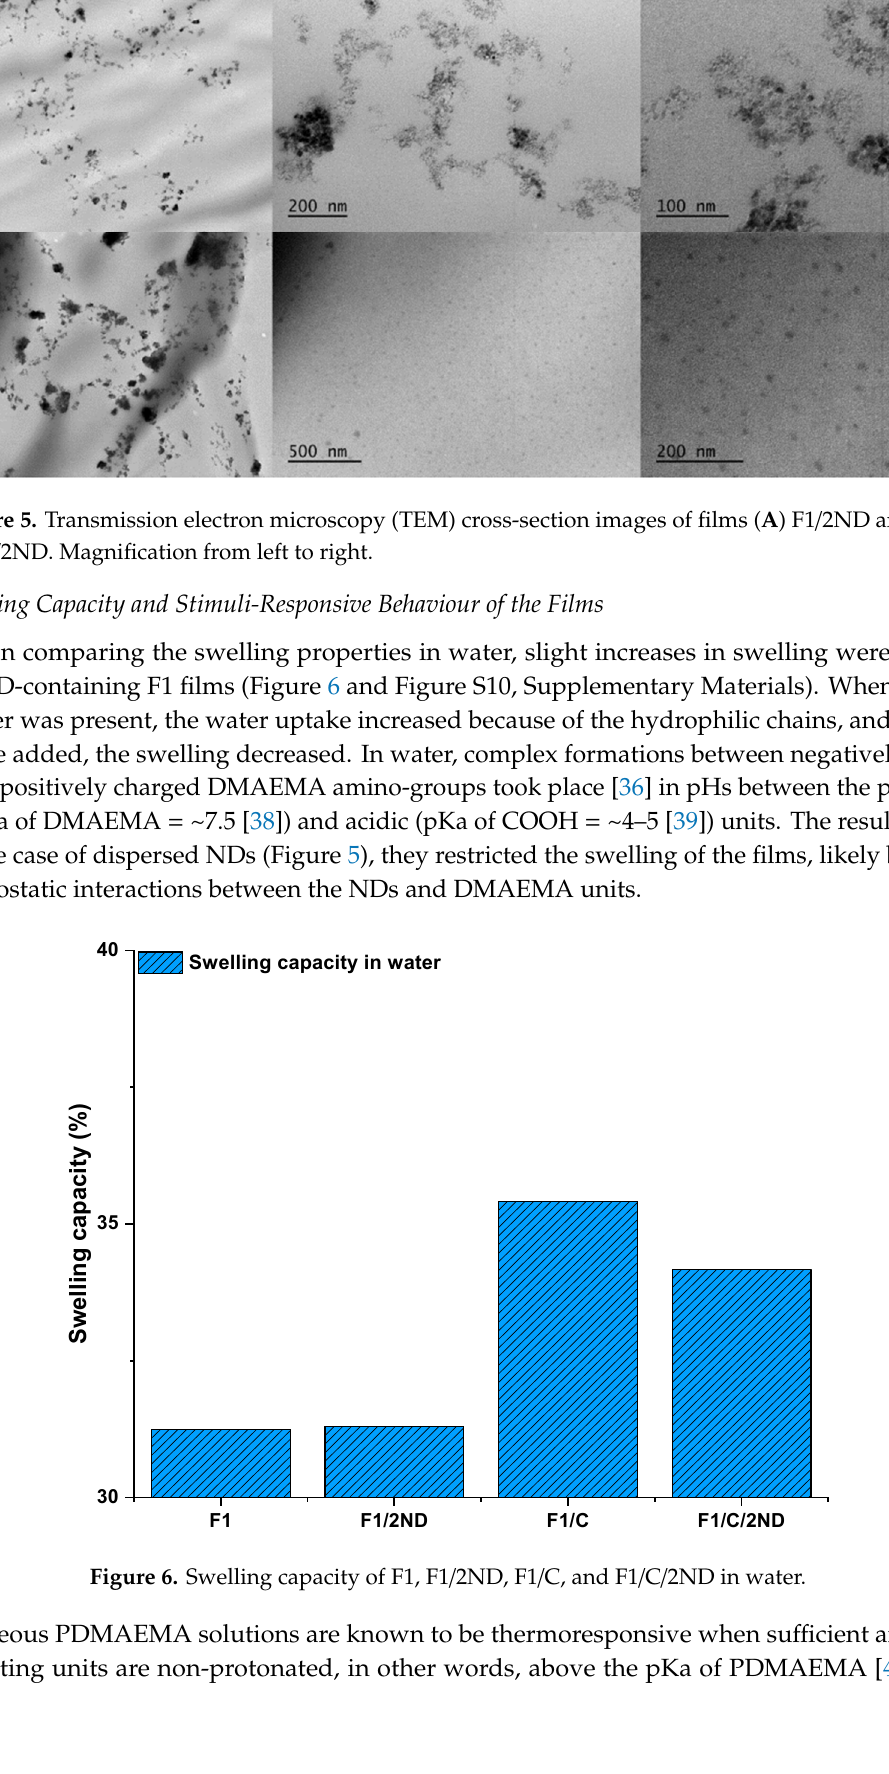
Figure 4. Scanning electron microscopy (SEM) cross-section images of films ( A ) F1, ( B ) F1/2ND, ( C ) F1/C, and ( D ) F1/C/2ND. Scale bar = 10 um.